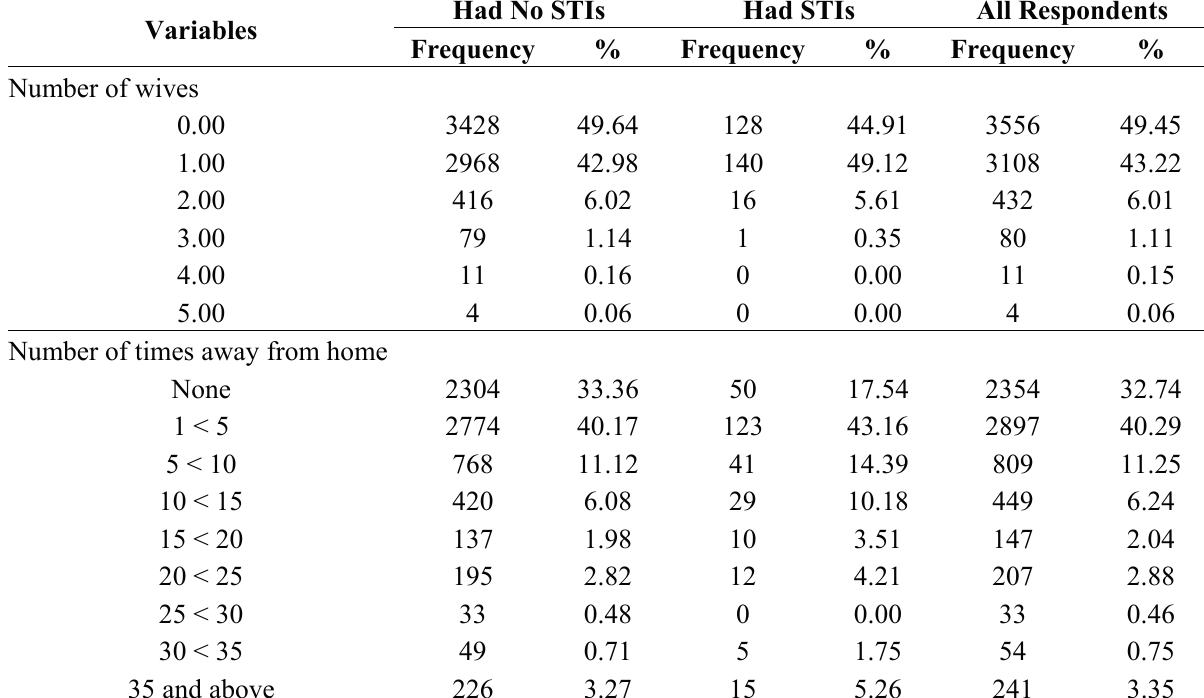
Table 2. Home absenteeism and men’s number of casual sex